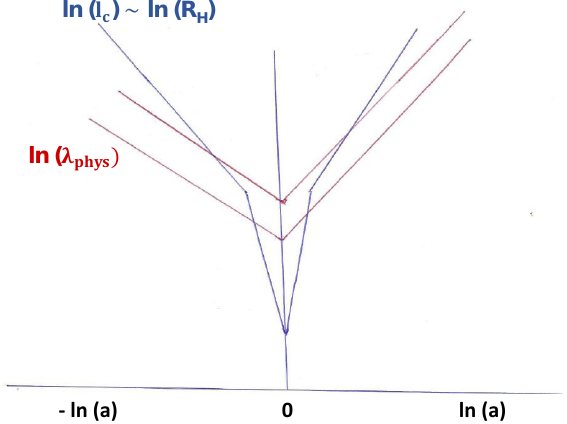
Figure 2. Qualitative comparison between evolution of the curvature scale, in blue, and cosmological scales, in red, in bouncing models. During classical evolution, the curvature scale coincides with the Hubble radius. The scale factor at the bounce is normalized to one; hence, the origin corresponds to the bounce, where the scale factor attains its minimal value. The negative and positive horizontal axis correspond to the contracting and expanding phases, respectively. In the plot, the transitions from dust to radiation domination, and the bounce itself, are qualitatively depicted by sharp transitions. In reality they are smooth, but it does not alter the physical conclusions presented in the